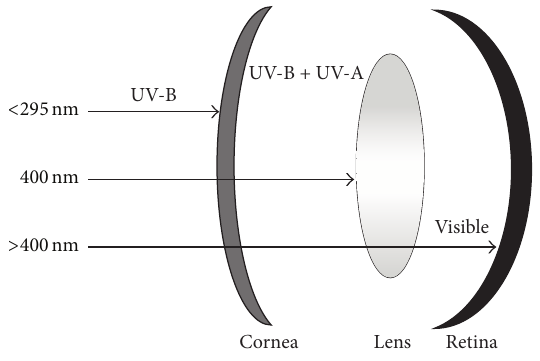
Figure 1: Wavelength transmission of the adult human eye.